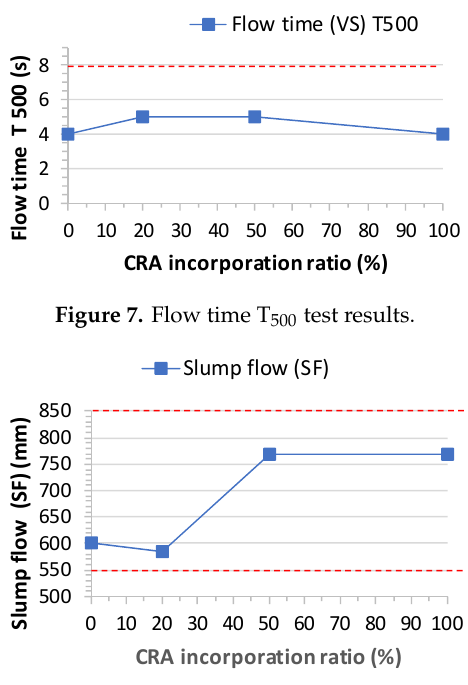
Figure 8. Slump flow test results.